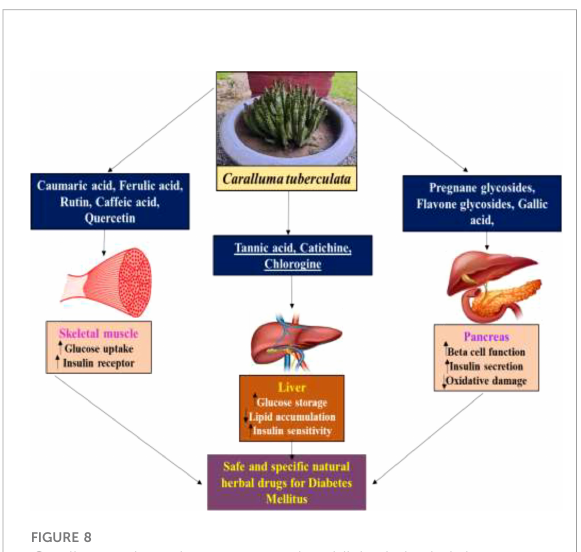
FIGURE 8 Caralluma tuberculata as a natural antidiabetic herbal